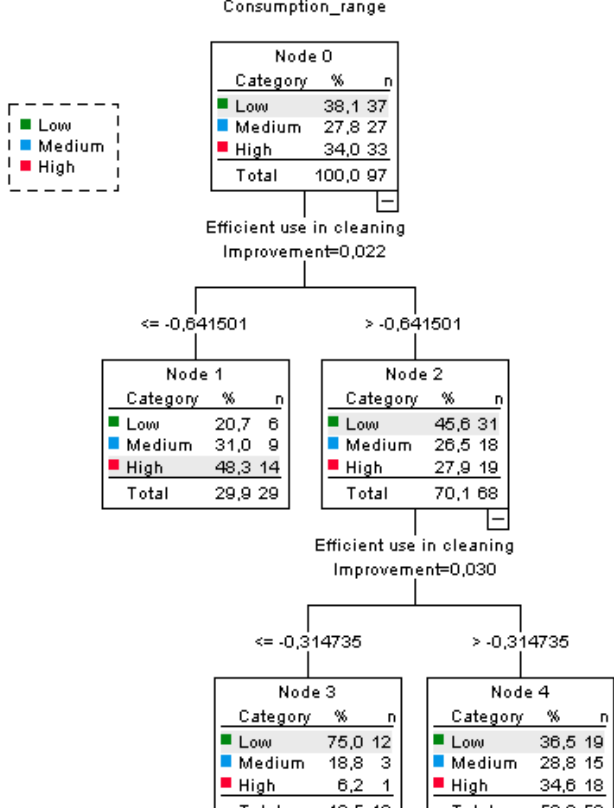
Figure 2. Summary tree of the CART method on the joint influence of knowledge, values/needs, and attitudes to predict the range of household consumption. (Source: Authors).